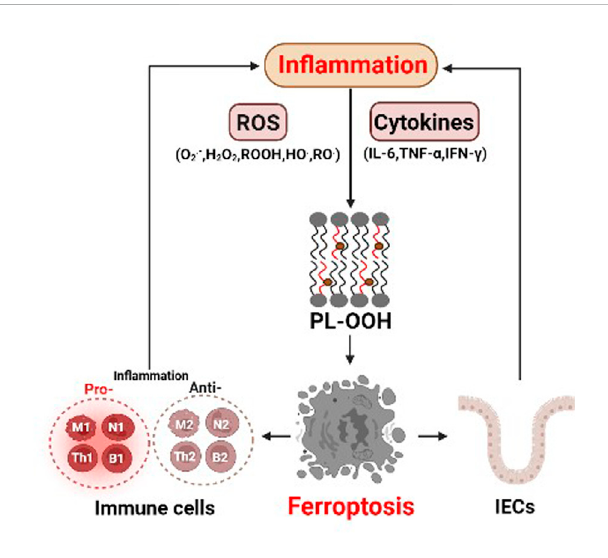
FIGURE 2 The interaction between ferroptosis and in fl ammation. Abundant reactive oxygen species (ROS) in in fl ammation can lead to lipid peroxidation and ferroptosis. In addition, various cytokines, such as IL-6, TNF- α andIFN- γ ,may play critical roles ininducing ferroptosis. The pro-in fl ammatory and anti-in fl ammatory cells themselves both can undergo ferroptosis, which directly affects in fl ammatory responses. intestinal epithelial cells (IECs) intestinal epithelial